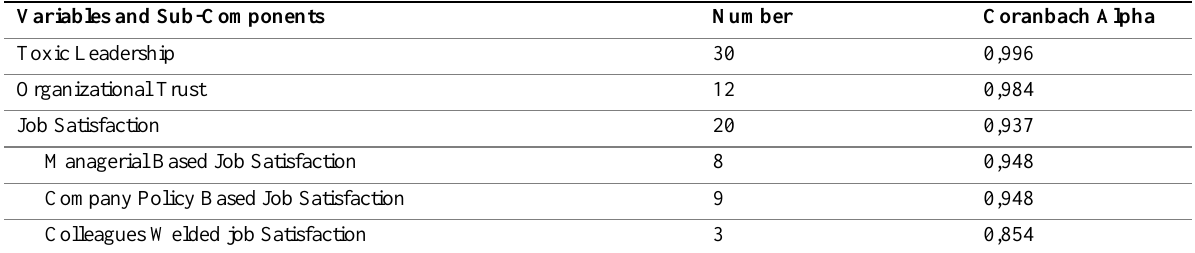
Table 1: Degree of Reliability of Scale Variables and